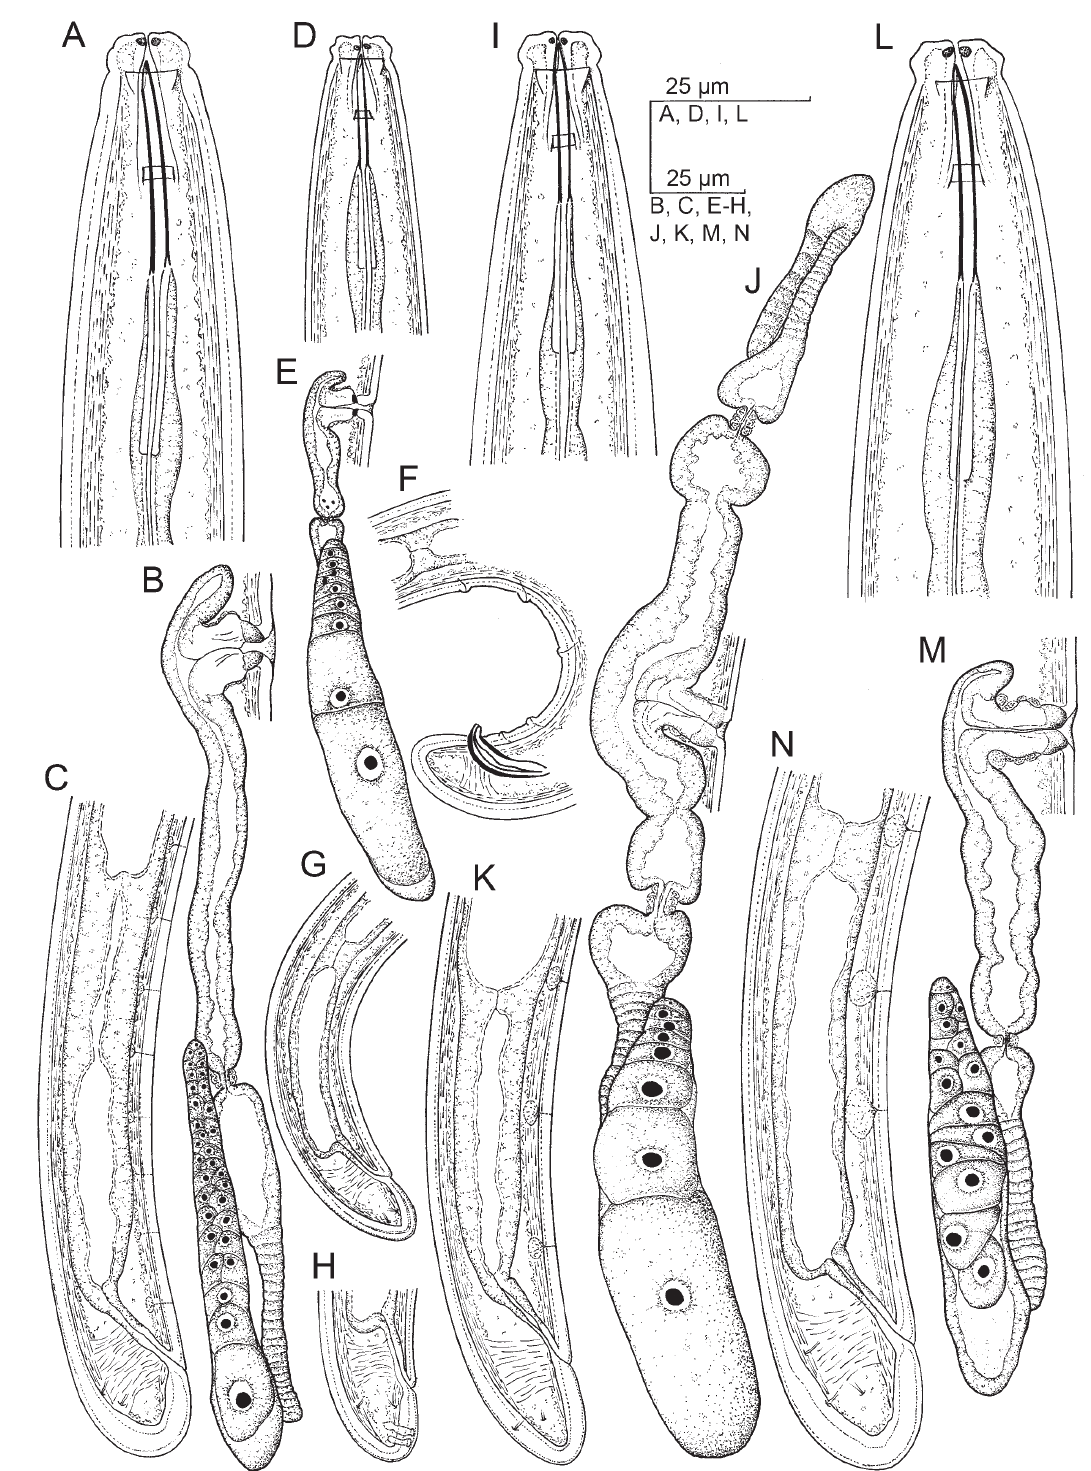
Fig. 1. Iberian Pungentus species. – A-C . Pungentus clavatus Ahmad & Jairajpuri, 1979 . – D-H . Pungentus engadinensis (Altherr, 1950) . – I-K . Pungentus marietani Altherr, 1950 . – L-N . Pungentus silvestris Coomans & Geraert, 1962. – A, D, I, L. ♀, anterior region in lateral median view. B, E, J, M. ♀, genital system. C, G, K, N. ♀, posterior body region. F. ♂, posterior body region. H. ♀, caudal